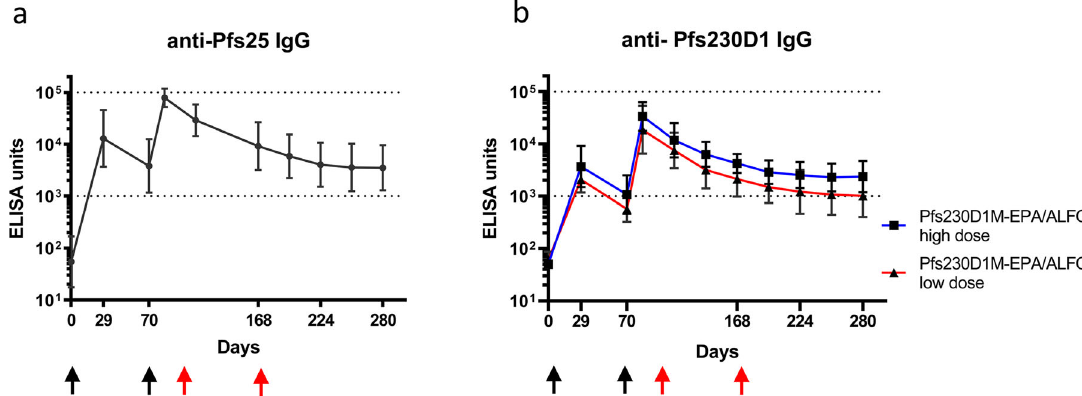
Fig. 1 Antibody levels following vaccination with Pfs25-EPA or Pfs230D1-EPA with ALFQ adjuvant. Serum ELISA units of Rhesus monkeys ( n = 5) vaccinated with Pfs25-EPA ( a ) or Pfs230D1-EPA ( b ) formulated with ALFQ adjuvant. Sera from each animals were analyzed in triplicate, and the y-axis represents the geometric mean of ELISA units with 95% con fi dence interval. Black arrows indicate the days of vaccination; red arrows indicate the days of SMFA. EU for the high-dose group of Pfs230D1-EPA was signi fi cantly higher than that for the low-dose group; p = 0.032 by GEE